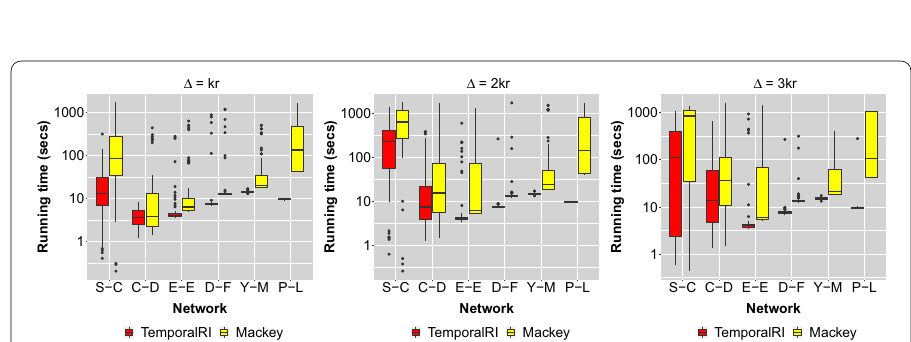
Fig. 7 Comparison between TemporalRI and Mackey’s algorithm on the set of queries with k = 9 contacts on varying (cid:31) . Boxplots of running times are built on the set of experiments in which both algorithms ended before the timeout. Network names are